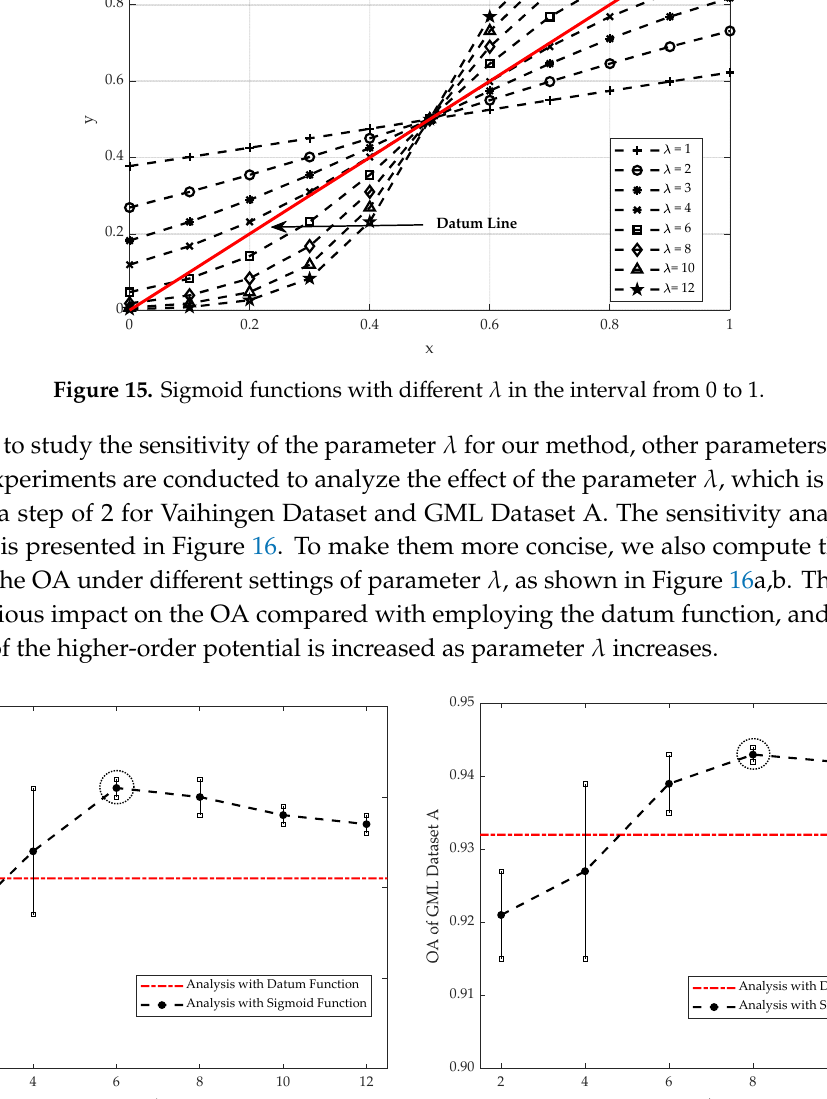
Figure 16. ( a ) Parameter λ analysis in Vaihingen Dataset; ( b ) Parameters λ analysis in GML Dataset A.